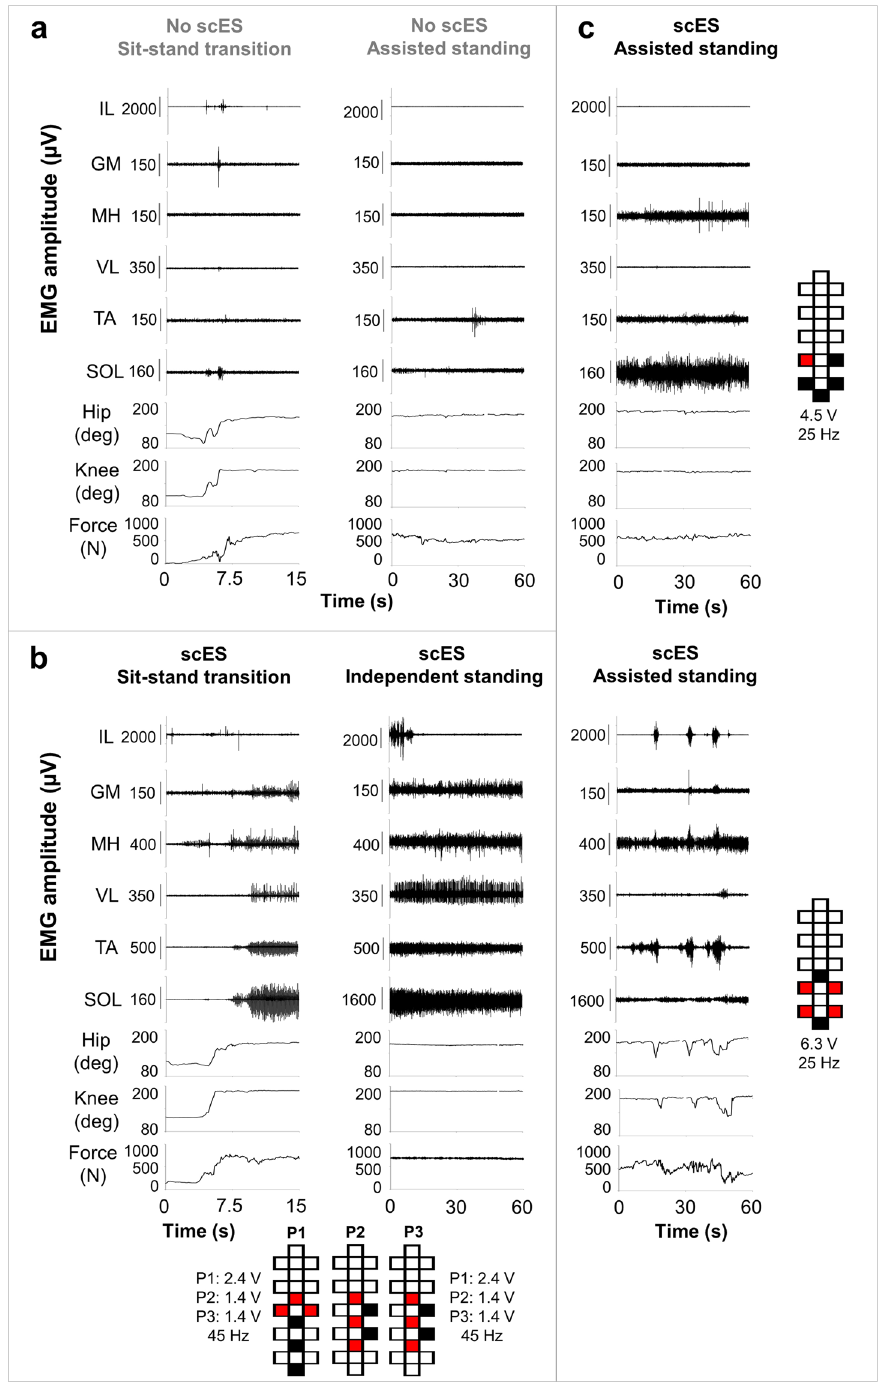
Figure 1. EMG, lower limb joint angles and ground reaction forces during sit-to-stand transition and during standing. Electromyography (EMG), hip and knee joint angle, and ground reaction forces recorded from research participant A59 during: ( a) sit-to-stand transition and standing with external assistance for hips and knees extension (assisted standing) without spinal cord epidural stimulation (scES); ( b) sit-to-stand transition and independent standing using scES; the participant held the hands of a trainer for balance control; (c) assisted standing with scES resulting from an overall continuous activation pattern (top) and from an EMG pattern characterized by the alternation of EMG bursts and little activation (bottom). Stimulation amplitude, frequency and electrode configuration (cathodes in black, anodes in red, and inactive in white) are reported for each standing condition. In ( b) , the participant was stimulated with 3 programs delivered sequentially at 15 Hz, resulting in an ongoing 45 Hz stimulation frequency. EMG was recorded from the following muscles of the right lower limb: IL, iliopsoas; GL, gluteus maximus; MH, medial hamstring; VL, vastus lateralis; TA, tibialis anterior; SOL,